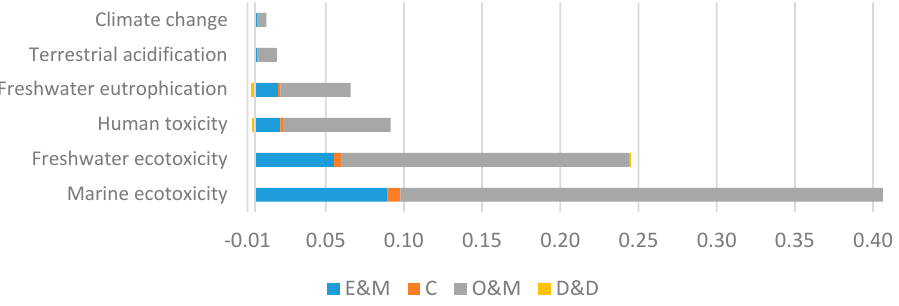
Figure 4. Normalization impacts associated with the life cycle of the reference HYSOL plant per category and life phase.